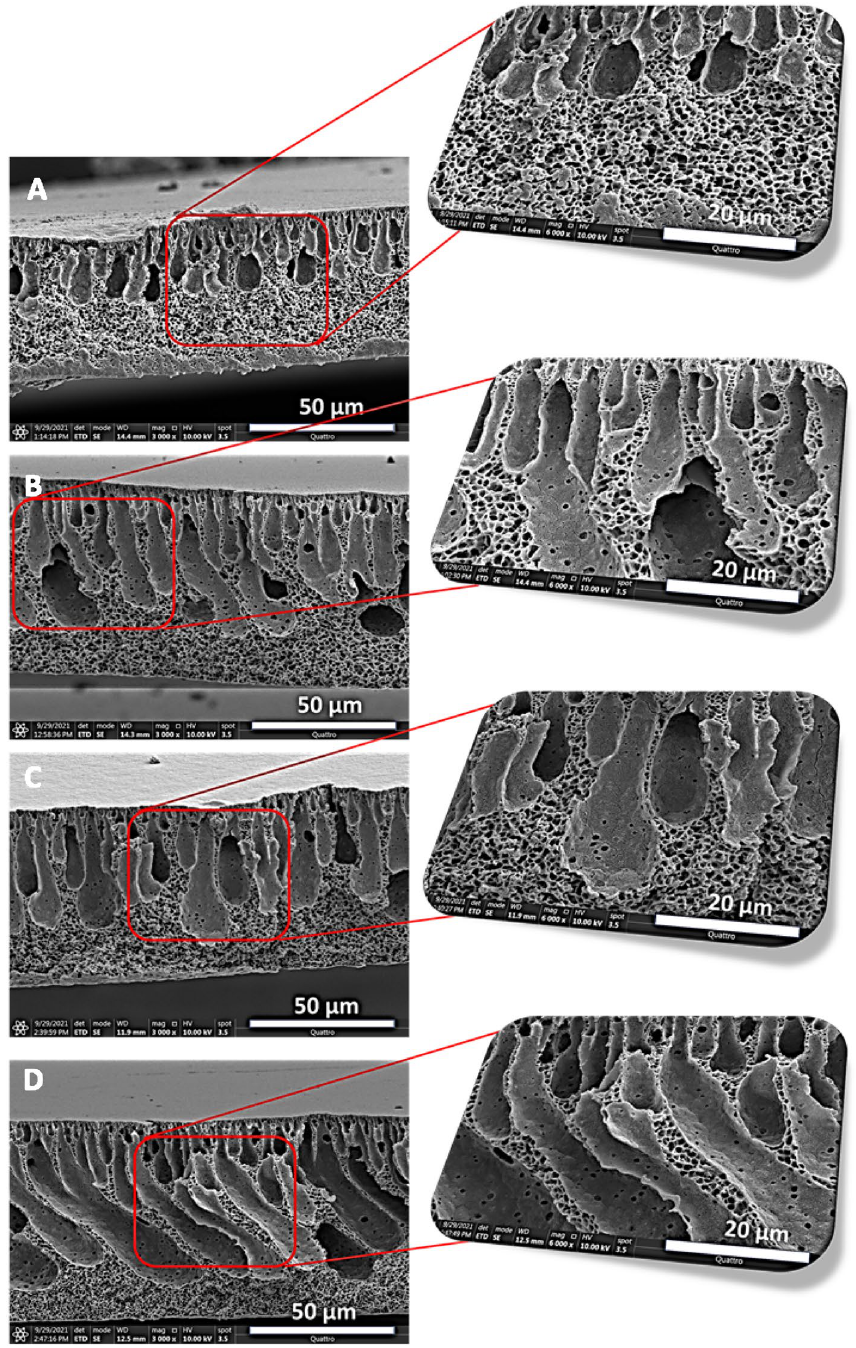
Figure 5. Cross-sectional views of the pristine and mixed matrix membranes ( A ) M-0 , ( B ) M-1 , ( C ) M-2 , and ( D ) M-3